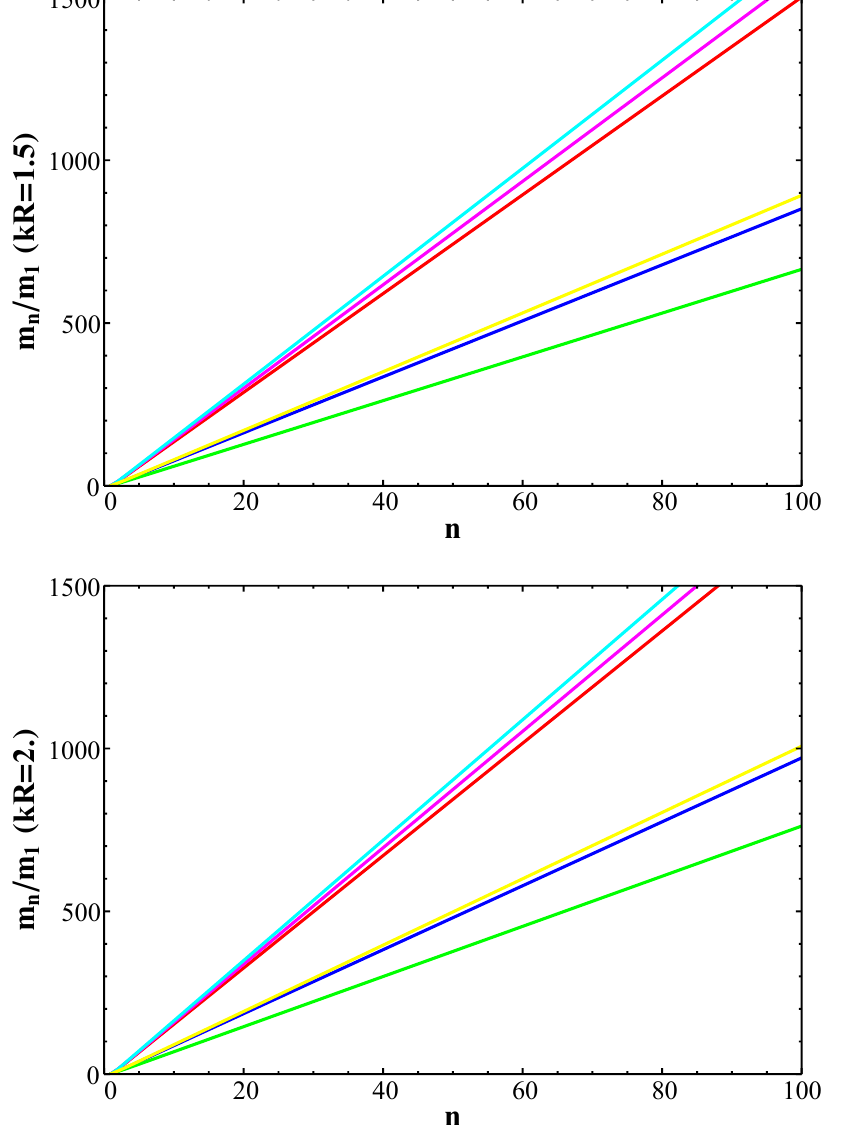
Figure 13 . (Top) Approximate linear growth of the relative dark photon KK mass ratio m n /m 1 as a function of n assuming kR = 1 . 5 for various choices of (( kR ) τ, a W ) =(1/2,1/2) [red], (1/2,1) [blue], (1/2,3/2) [green], (1,1/2) [magenta], (3/2,1/2) [cyan] and (1,1) [yellow], respectively. (Bottom) As in the previous panel, but assuming kR = 2 . 0